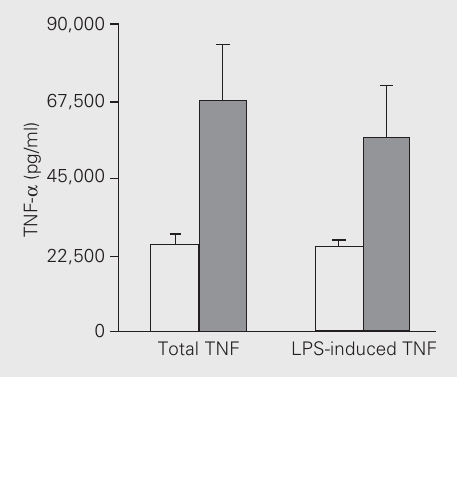
Figure 4. Tumor necrosis factor alpha (TNF- α ) produc- tion in maximally lipopolysaccharide (LPS)-stimulated whole blood cultures from healthy controls and mal- nourished children. Data are reported as mean ± SEM for TNF- α in 24-h culture supernatants. Open columns, controls (N = 18); filled columns, malnourished sub- jects (N = 11). On the left, total TNF- α production in maximally stimulated cultures. On the right, TNF- α production after subtracting the background (“sponta- neous”) release for each patient. Differences between these groups were statistically significant (P = 0.002, t - test).